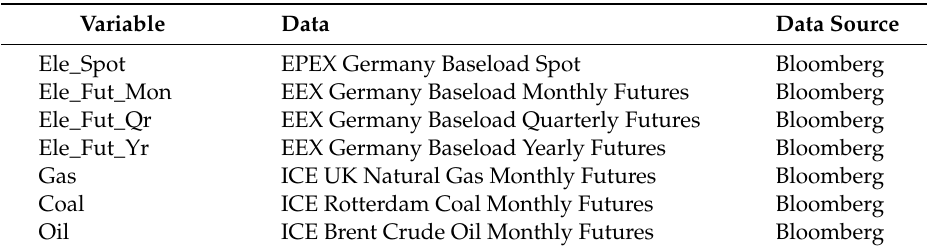
Table 3. Variables in the